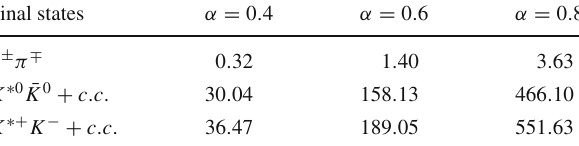
→ V P with dif- c 2 is 3927.2 MeV as in PDG [39] c 2